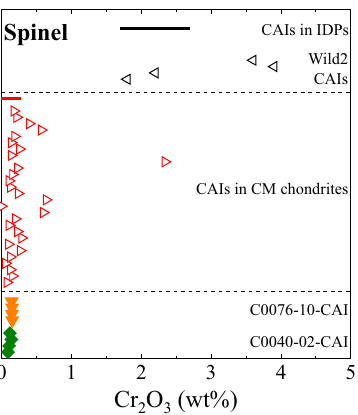
Fig.5|ConcentrationsofCr 2 O 3 inspinelfromthetwoRyuguCAIs. Spineldatain CAIs from CM chondrites 38,87 – 92 , CAI-like Wild 2 particles 62 , and CAI-like IDP 14 are shownforcomparison.TheredandblackbarsrepresenttheCr 2 O 3 rangesinspinel in CAIs in a CM chondrite 92 and in CAI-like IDP (Spray) 14 .